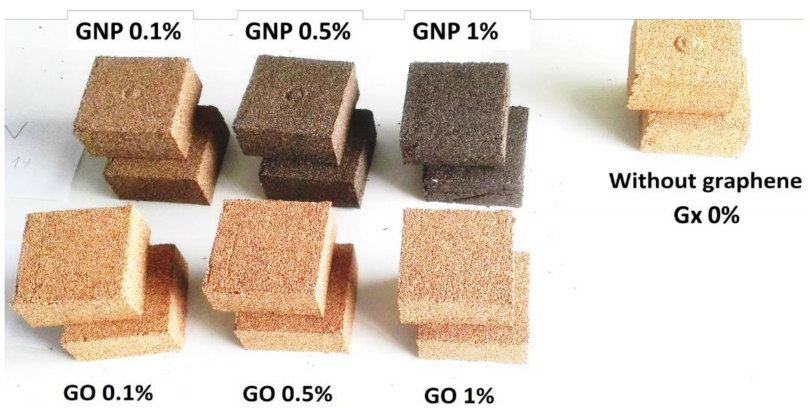
Figure 2. Example of samples subjected for quasi-static and dynamic testing.